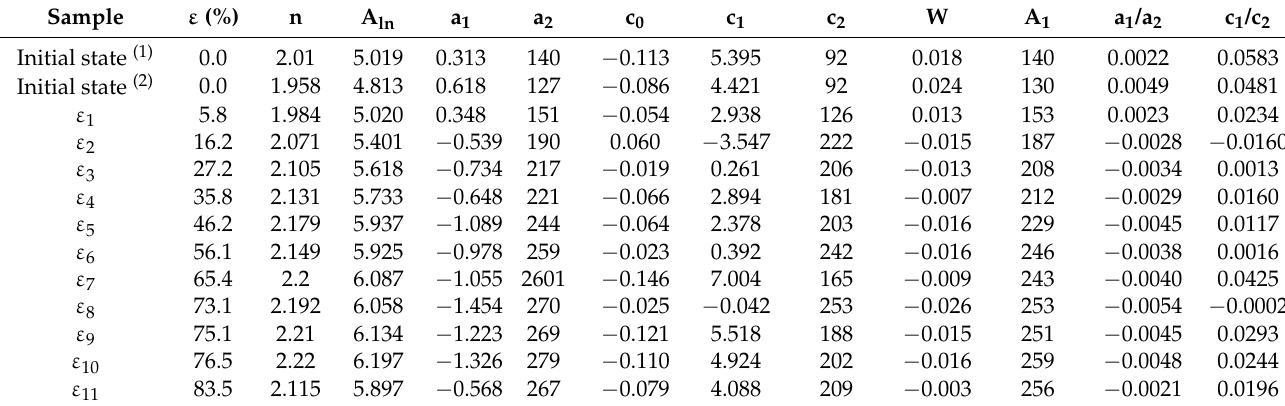
Table 5. The parameters of